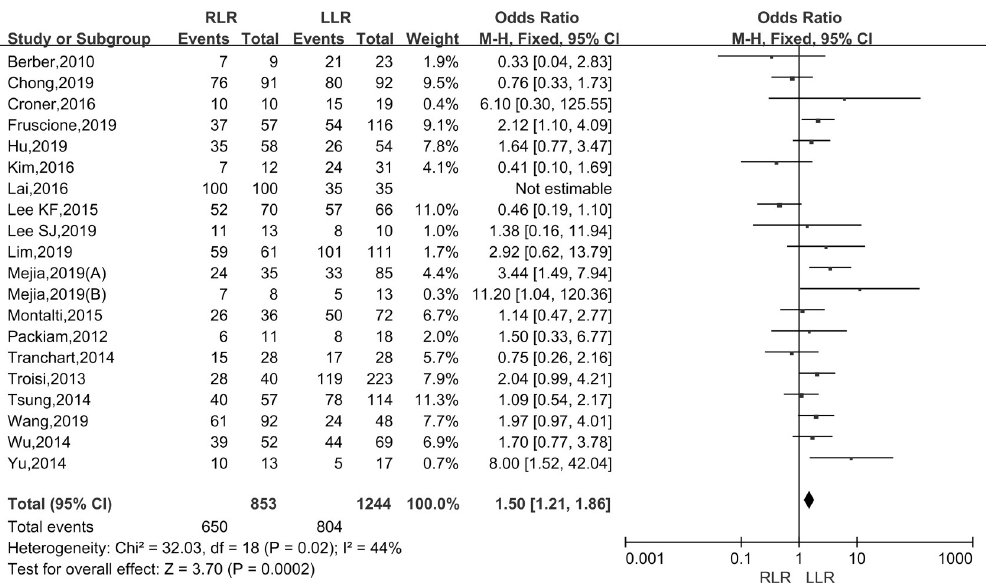
Fig 7. Forest plot of the meta-analysis on malignant lesions rate.